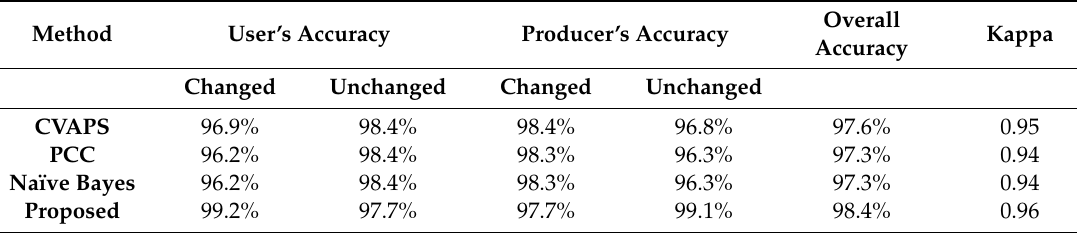
Table 3. Accuracy assessment of change detection in Experiment II.